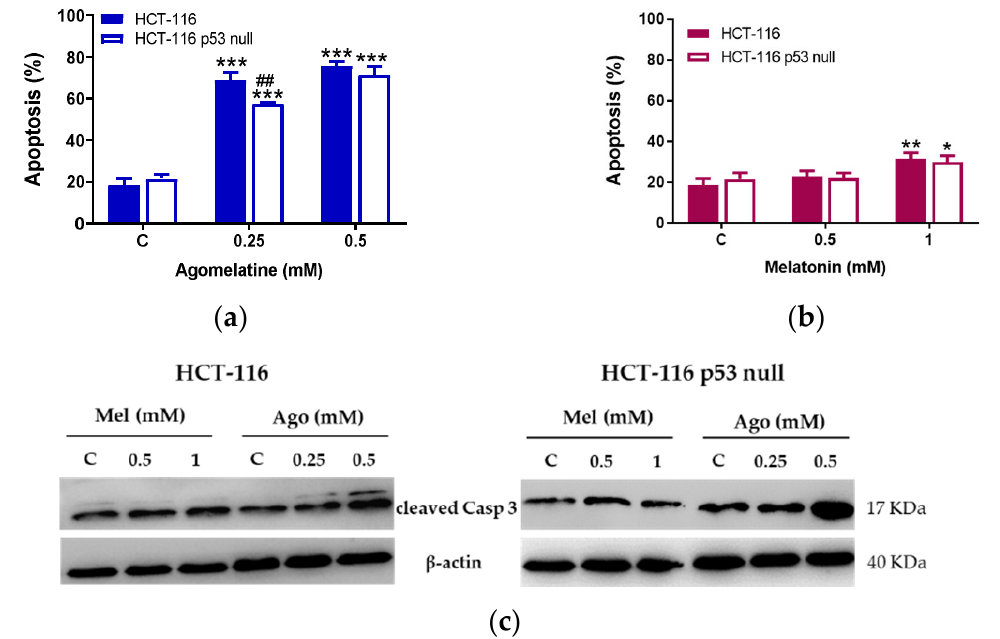
Figure 3. Percentage of apoptosis in HCT-116 and HCT-116-p53-null cells after agomelatine ( a ) and melatonin ( b ) treatments. Data represent the mean ± SD of three experiments performed in duplicate. * Values of p < 0.05 vs. C; ** p < 0.01 vs. C; *** p < 0.001 vs. C; ## p < 0.01 vs. HCT-116. ( c ) Expression of cleaved caspase-3 after treatment for 72 h with different doses of melatonin (Mel) and agomelatine (Ago) on HCT-116 and HCT-116 p53 null.